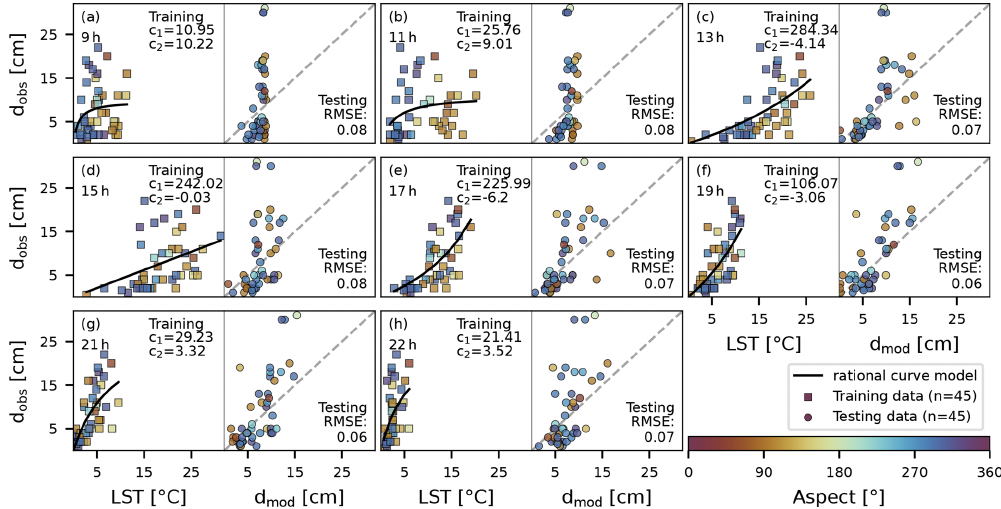
Figure 11. Least squares regression of a rational function of 50% of the debris-thickness measurements ( n = 45) with the arithmetic mean land surface temperature of a 2m buffered region around the GPS coordinates of debris-thickness measurement locations (training data) (a–h) . The adjacent panels show the comparison of modeled and observed debris thickness of the other 50% ( n = 45) with RMSE values to evaluate the prediction (testing data). Sample points are colorized by terrain